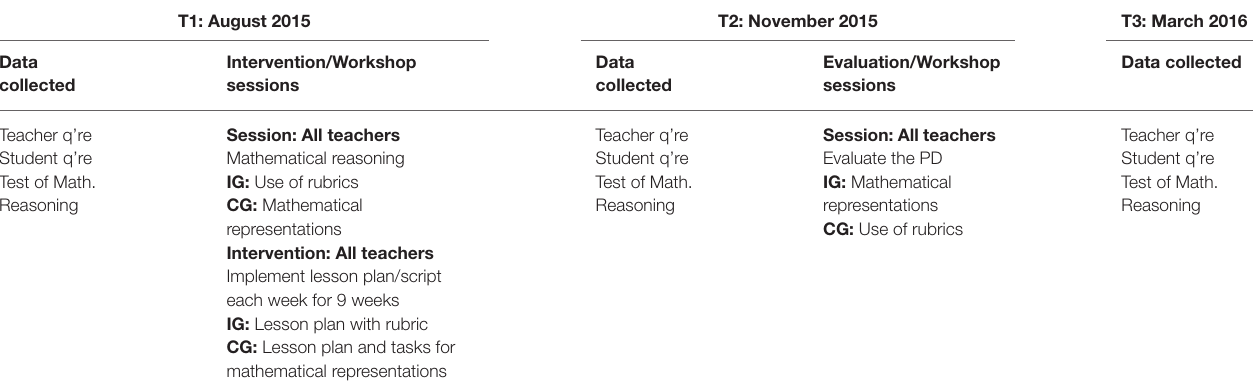
TABLE 1 | Research